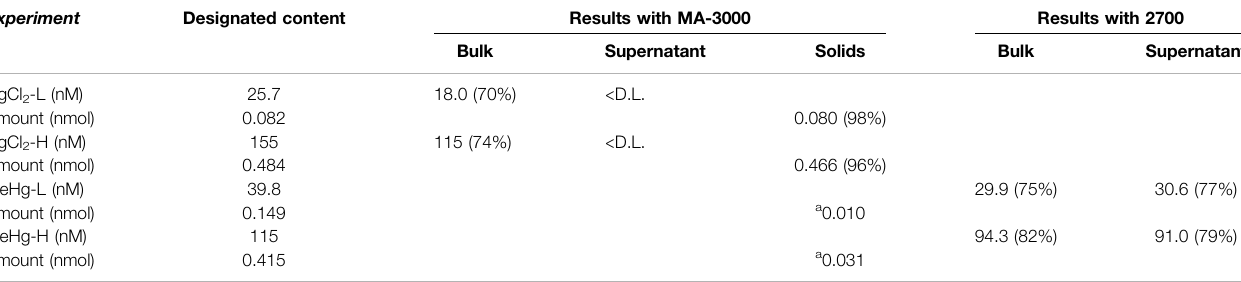
TABLE 1 | Phase distributions of Hg species after quenching of the NPs. The percentage in the parentheses refers to the fraction relative to the designated content.